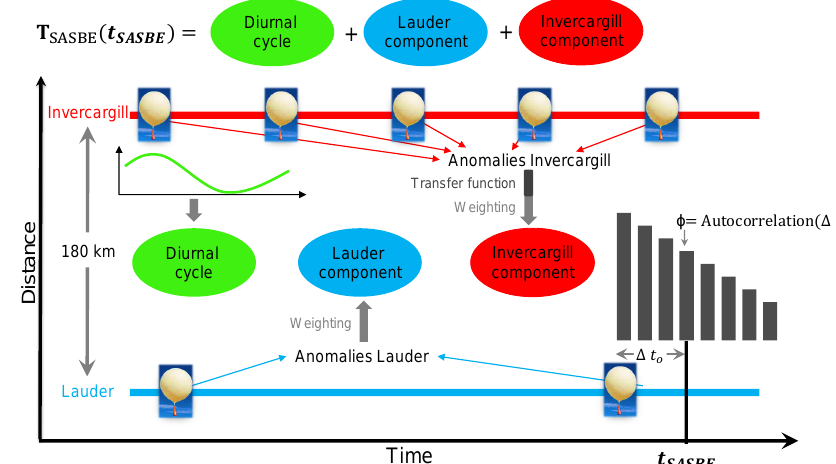
Figure 1. Schematic explanation of the temperature SASBE and its components. The diurnal cycle is determined from ERA5 as described in Sect. 3.1.1. To calculate the Invercargill component, a transfer function (see Sect. 3.1.2) and some weighting is applied to the temperature anomalies at Invercargill. To calculate the Lauder component, the temperature anomalies are weighted (see Sect. 3.2). Also shown is the weight φ , which is determined by the value of the autocorrelation function for the time difference between t and the closest Lauder radiosonde launch.